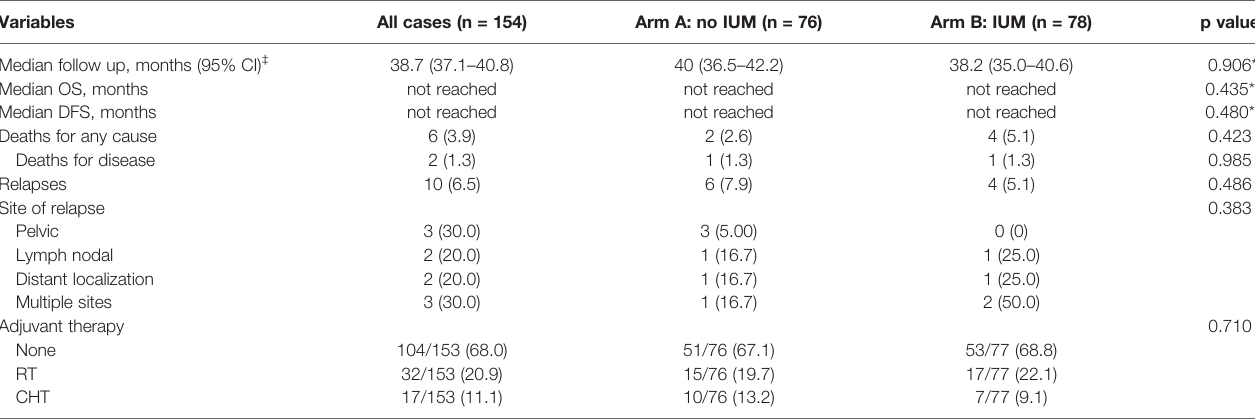
two multiple-site (vaginal + extra-abdominal and carcinomatosis); these patients had received a fi nal pathological diagnosis of intermediate-high (2) and high-risk (2) tumors. TABLE 4 | Oncological outcomes.